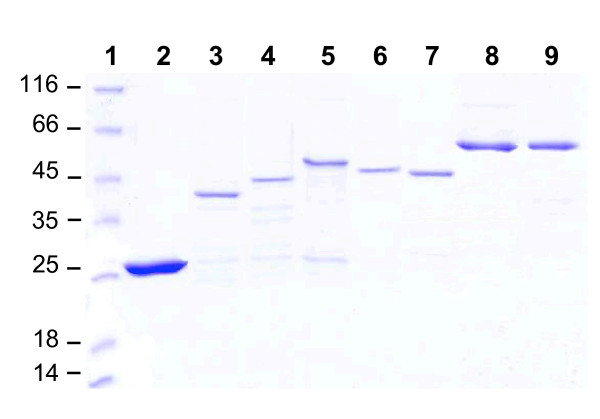
SDS-PAGE analysis of the purified recombinant proteins corresponding to the different VIR subfamilies. Bacterial recombinant VIR proteins were expressed and purified as described in the Methods section. Lanes, 1: Molecular mass marker; 2: GST; 3: VIR-A4; 4: VIR-B10; 5: VIR-C1; 6: VIR-C2; 7: VIR-C16; 8: VIR-E5; 9: VIR-E8.